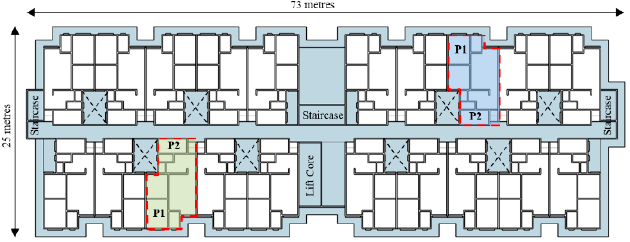
Figure 7. Typical floor plan of the PPR Seri Aman (a second generation building).